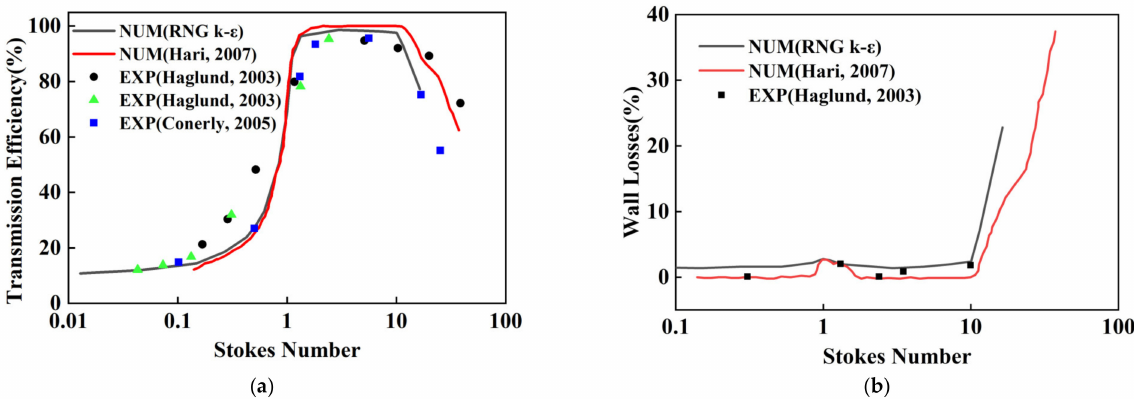
Figure 3. Comparison of numerical simulation and literature results [38]. ( a ) Transmission efficiency ( b ) Wall losses.